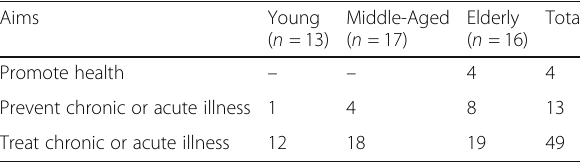
Table 2 Overview of the different aims for the use of HM for all focus groups. The numbers represent the absolute frequency of mentioning a specific aim with multiple answers being possible